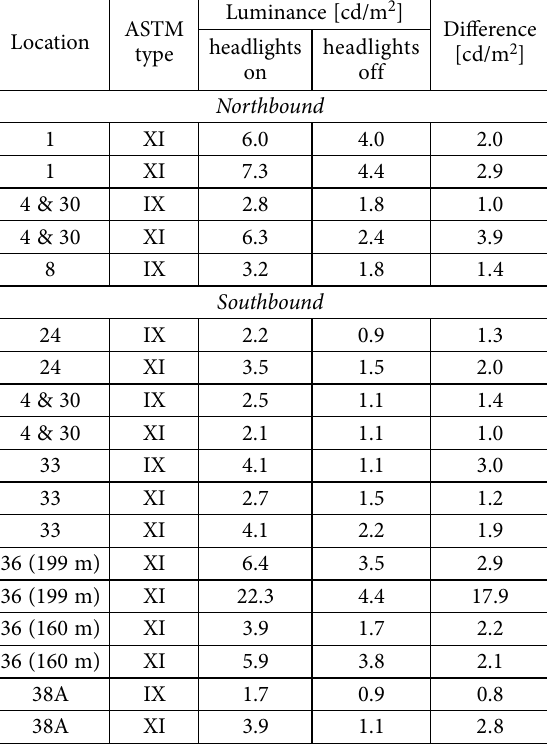
Table 1. Summary of photometric measurements and retroreflective luminances for each of the measured